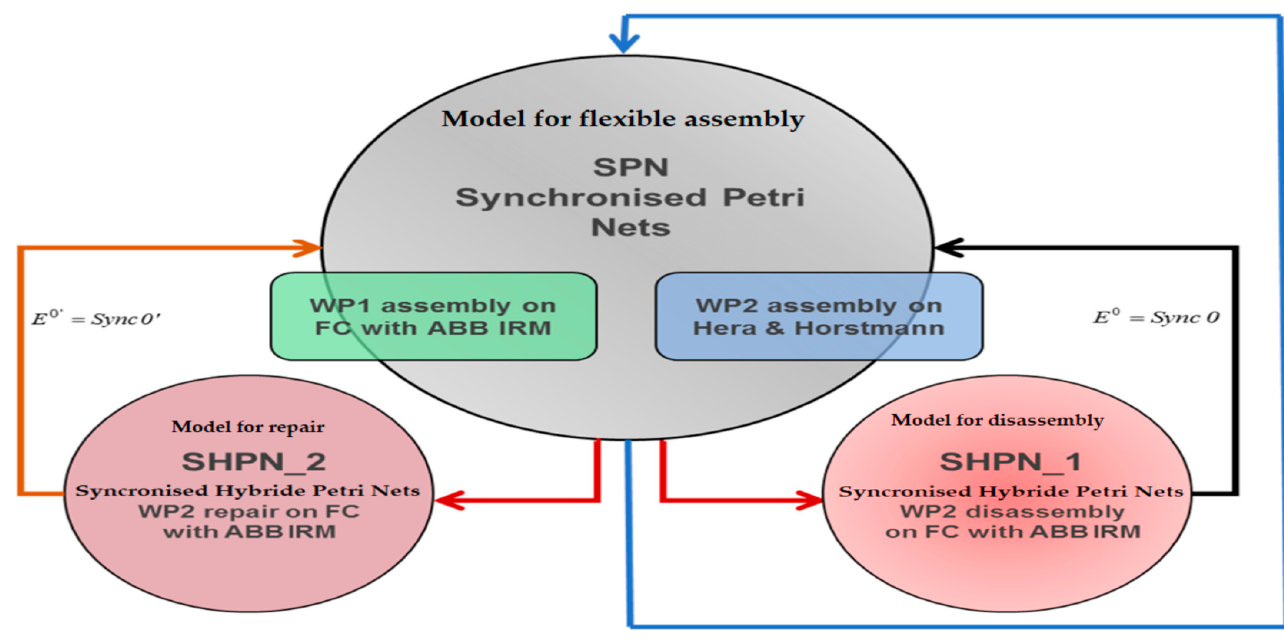
Figure 6. The block scheme of the interconnection through synchronization signals of the three operation models. operation